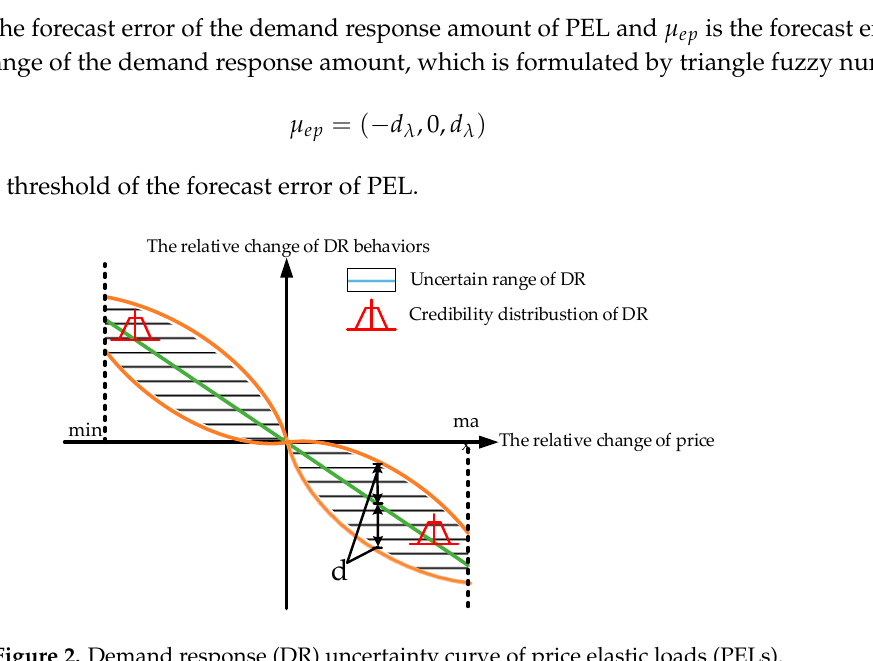
Figure 2. Demand response (DR) uncertainty curve of price elastic loads (PELs).